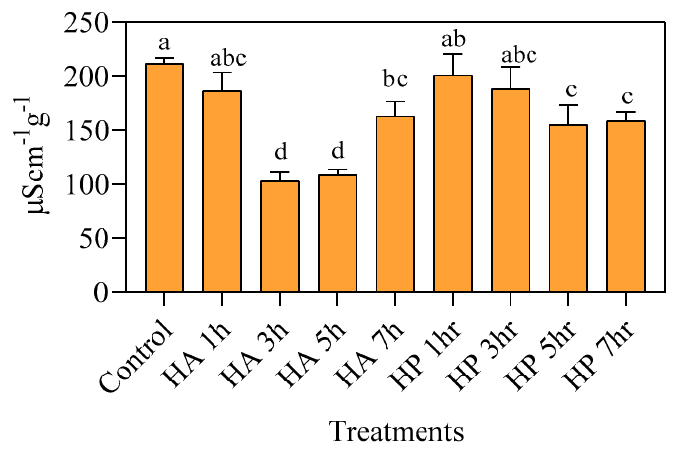
Figure 6. Effect of priming treatments on electrical conductivity and means (±SE) followed by the same letter on the bar do not differ significantly based on LSD at p < 0.05.